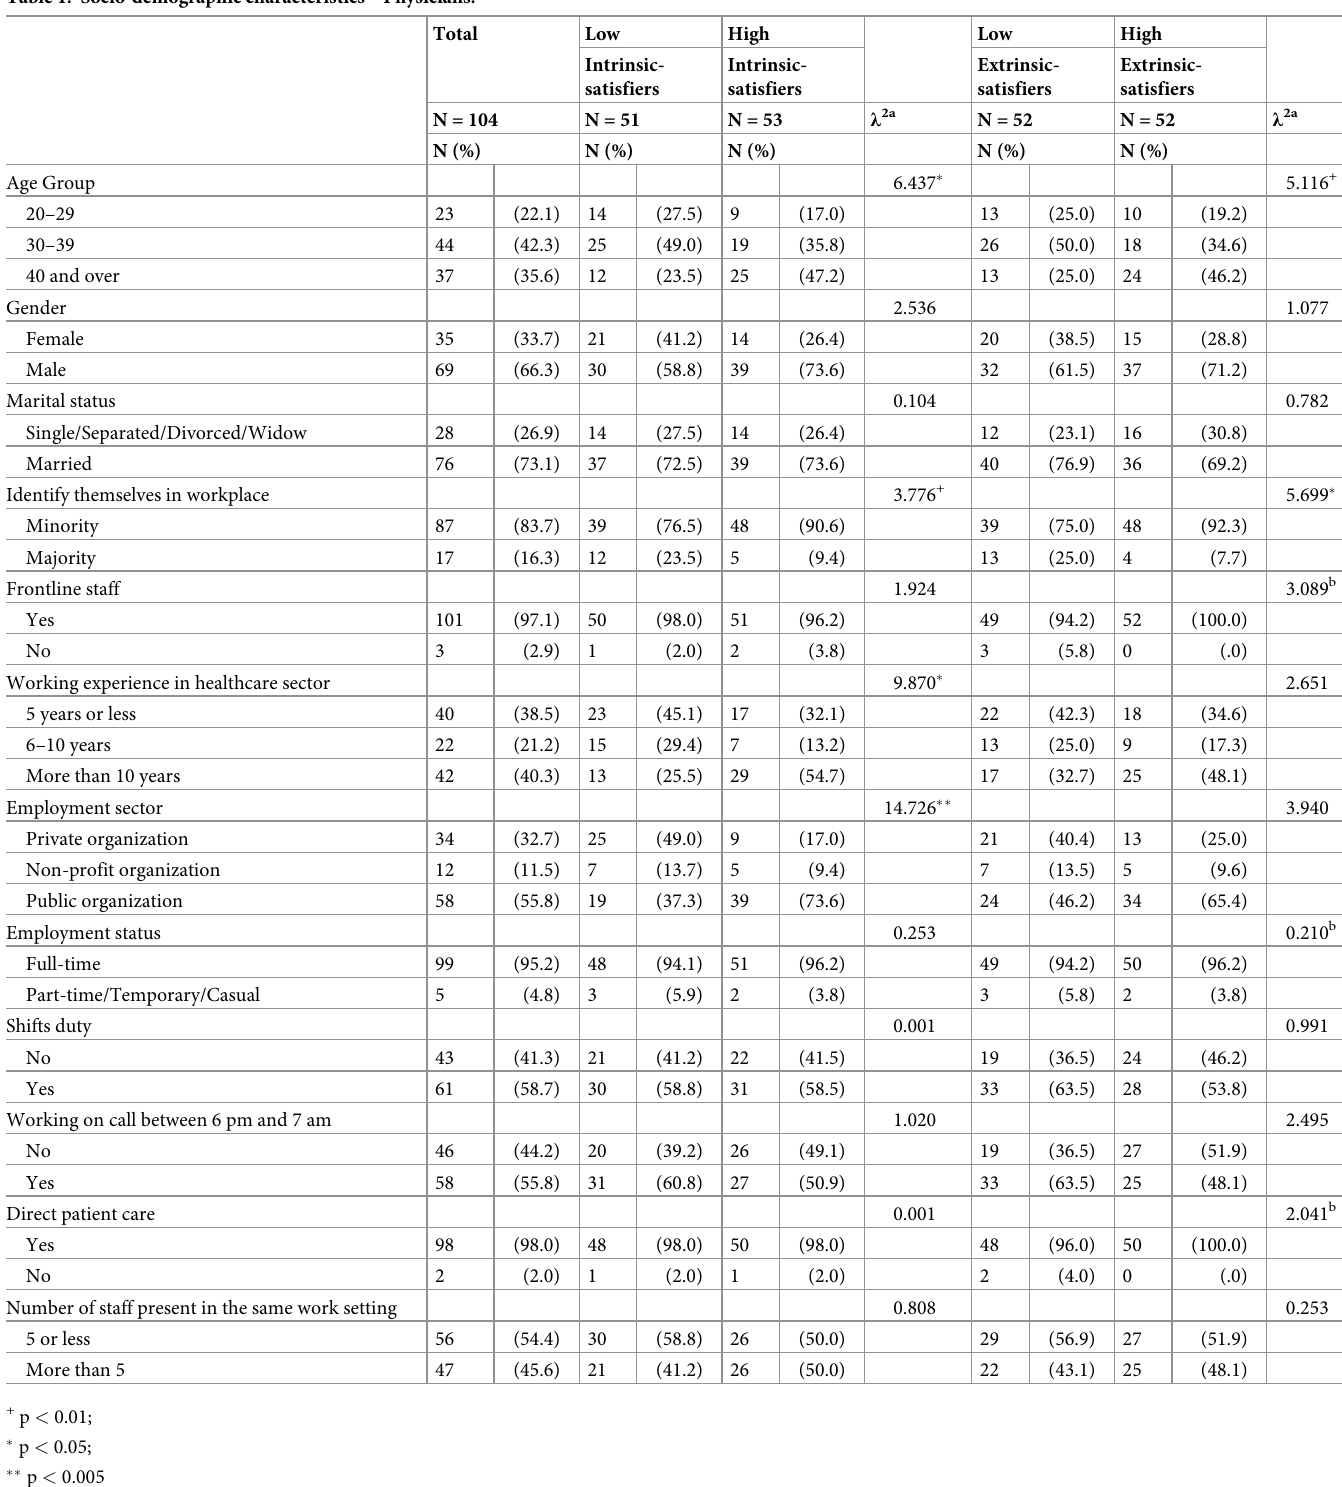
Table 1. Socio-demographic